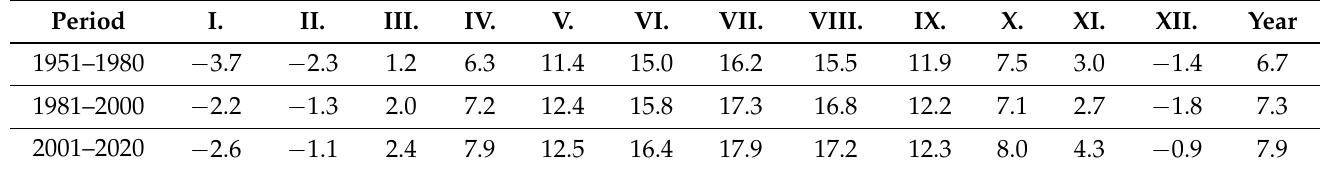
There are 1869 landslides registered in this area. Landslides are registered in the State Geological Institute of Dionýz Štúr databases and their locations were verified in the field. The database contains point landslides (those of small proportion) and area-wide landslides. The Atlas of slope stability maps SR [57] is the basis for digital layers that are continuously updated. Landslides take up almost 20 % (174.21 km 2 ) of the monitored